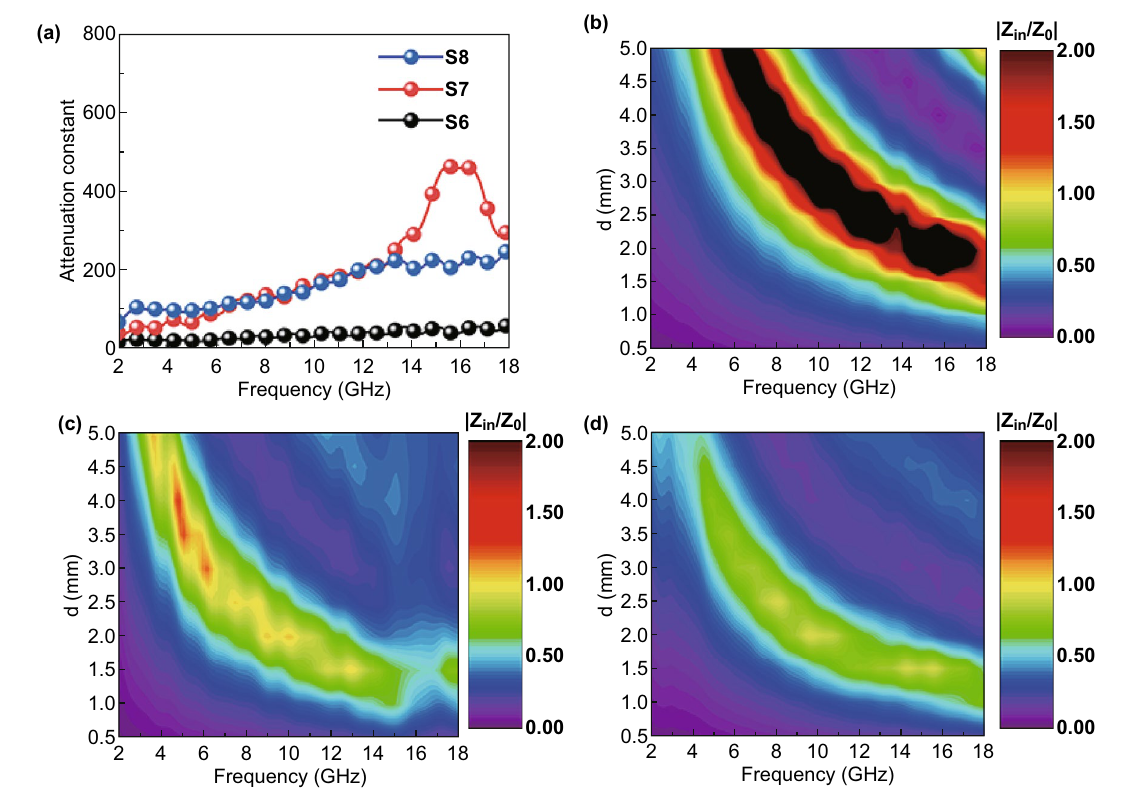
Fig. 8 a Attenuation constants results of S6, S7, and S8. 2D contour maps of | Z in / Z 0 | at different thicknesses from 2 to 18 GHz for b S6, c S7,